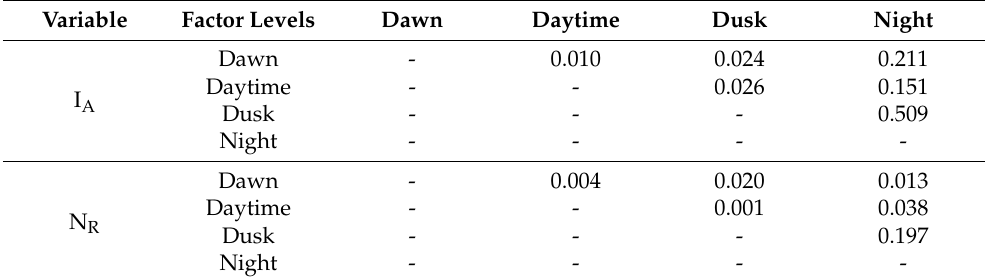
Figure 3. Boxplot of daily variation of dusky groupers’ activity levels, i.e., activity index (I A ) calcu-